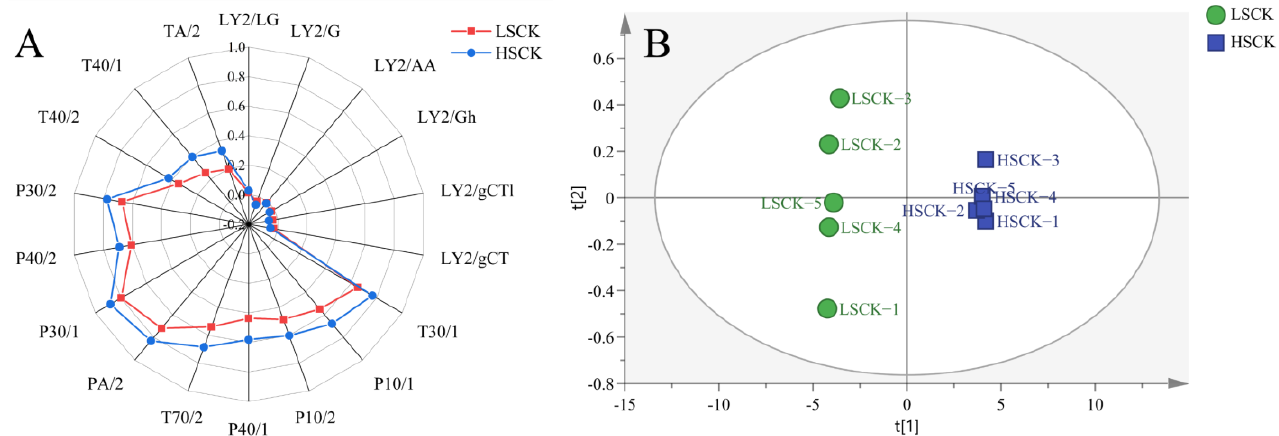
Figure 6. E-nose analysis. ( A ) Radar graph of the LSCK and HSCK. ( B ) PCA plot of the two fer- mented kohlrabies.